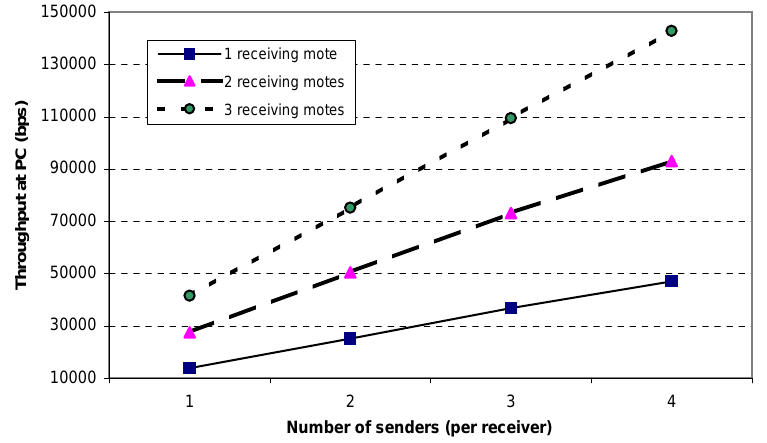
Figure 13. Aggregate throughput at PC as a function of the number of senders and receivers (maximum possible sending